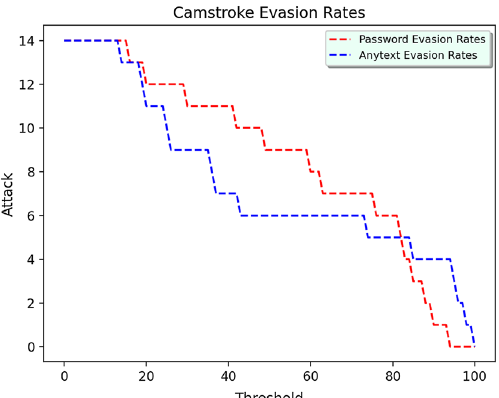
Fig. 19 Evasion rates on KeyTrac